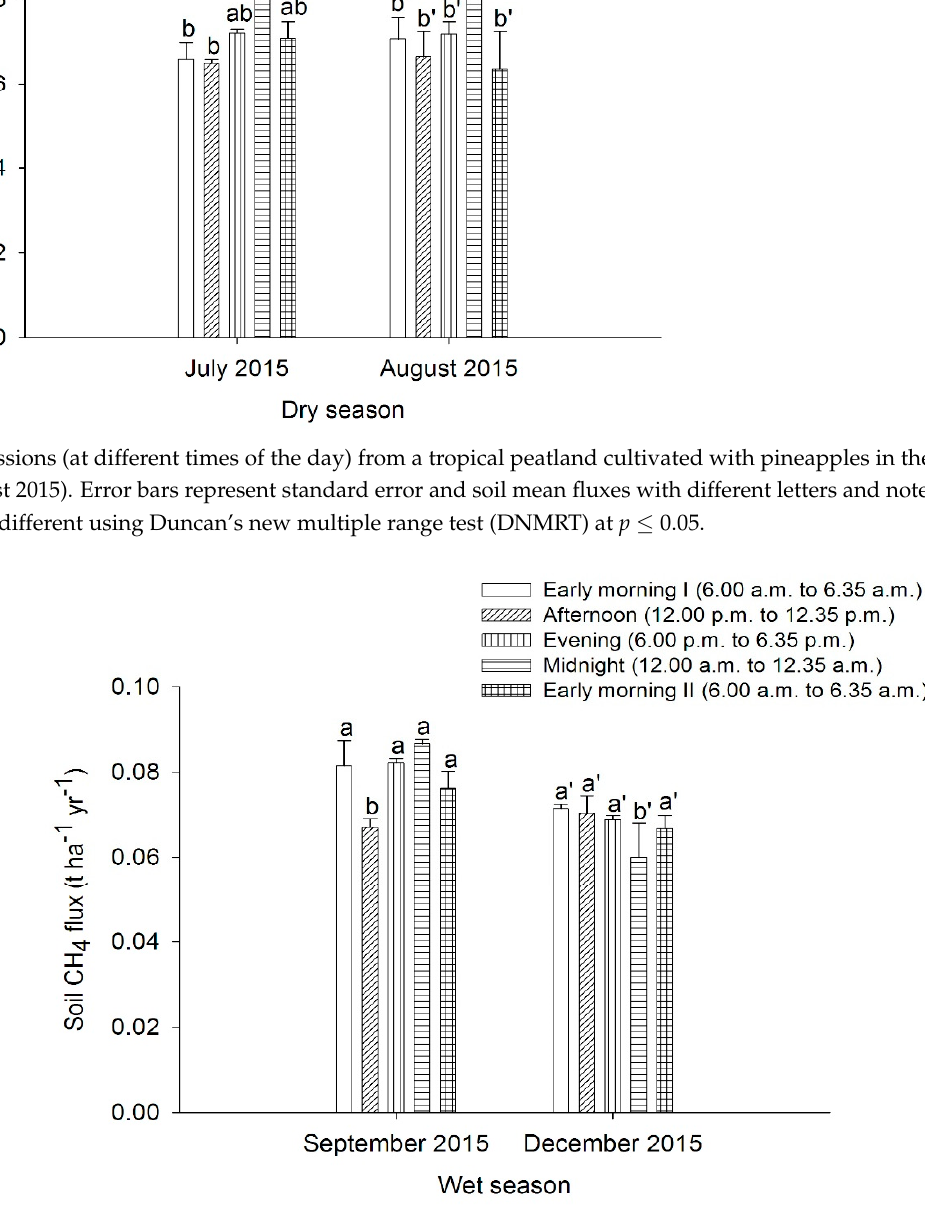
Figure 6. Soil CH 4 emissions (at different times of the day) from a tropical peatland cultivated with pineapples in the wet season (September and December 2015). Error bars represent standard error and soil mean fluxes with different letters and noted by prime are significantly different using DNMRT at p ≤ 0.05.